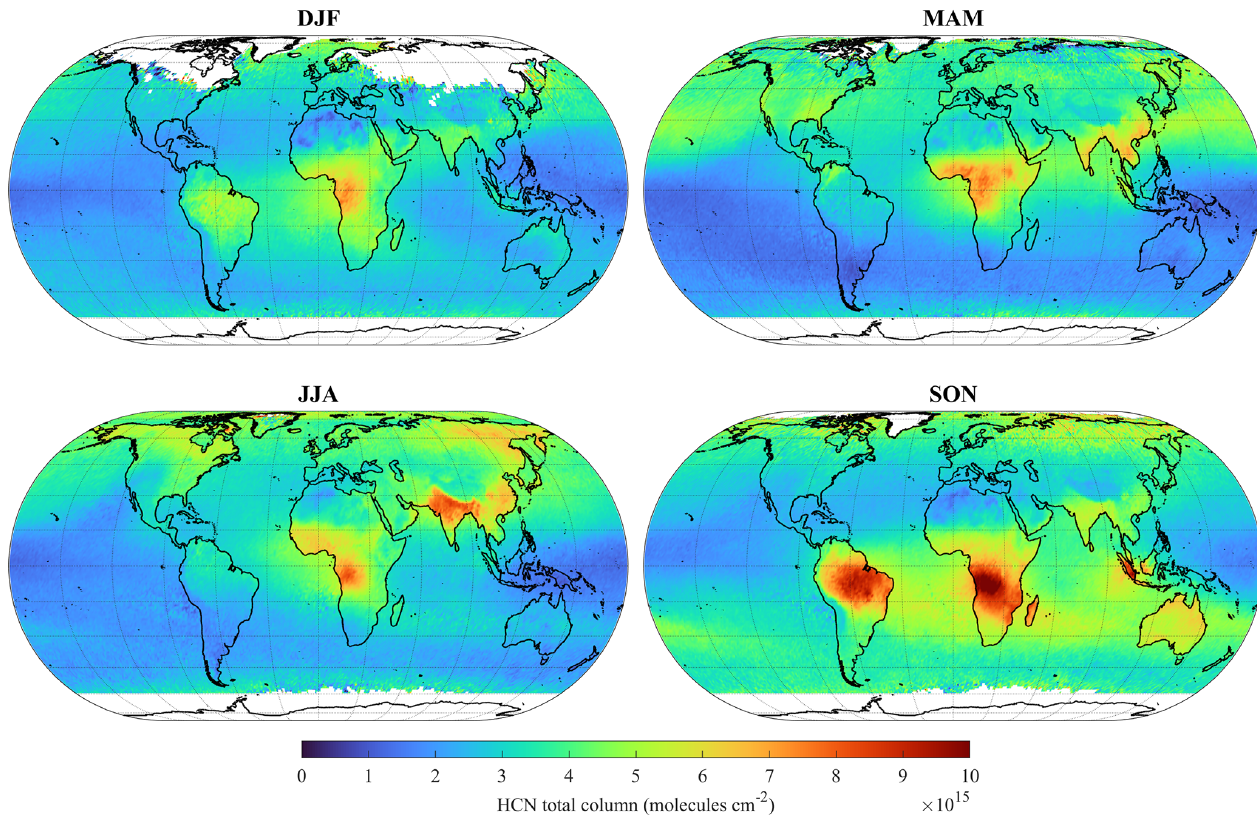
Figure A2. Seasonal means (on a 1 × 1 ◦ grid) of the HCN total columns (in moleculescm − 2 ) retrieved from the IASI/Metop-A measure- ments over the 2011–2014 time period. The HCN columns over the continents have been retrieved with the NN in emission regime, whereas the NN in transport/mixing regime has been used over the